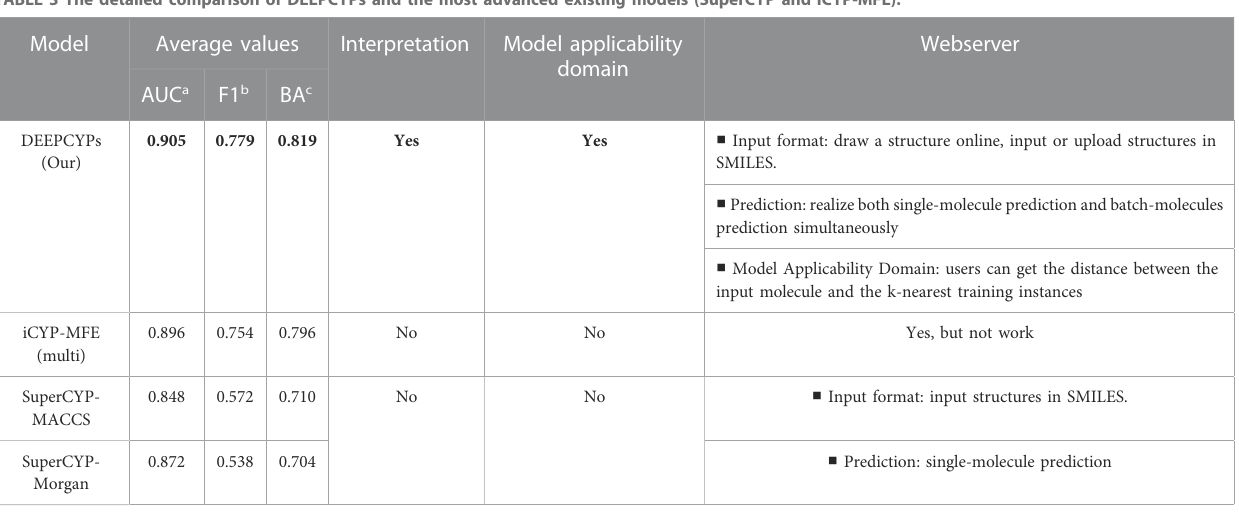
(Figure 6A, left). Existing machine learning-based predictive models, including our multi-task FP-GNN model, are